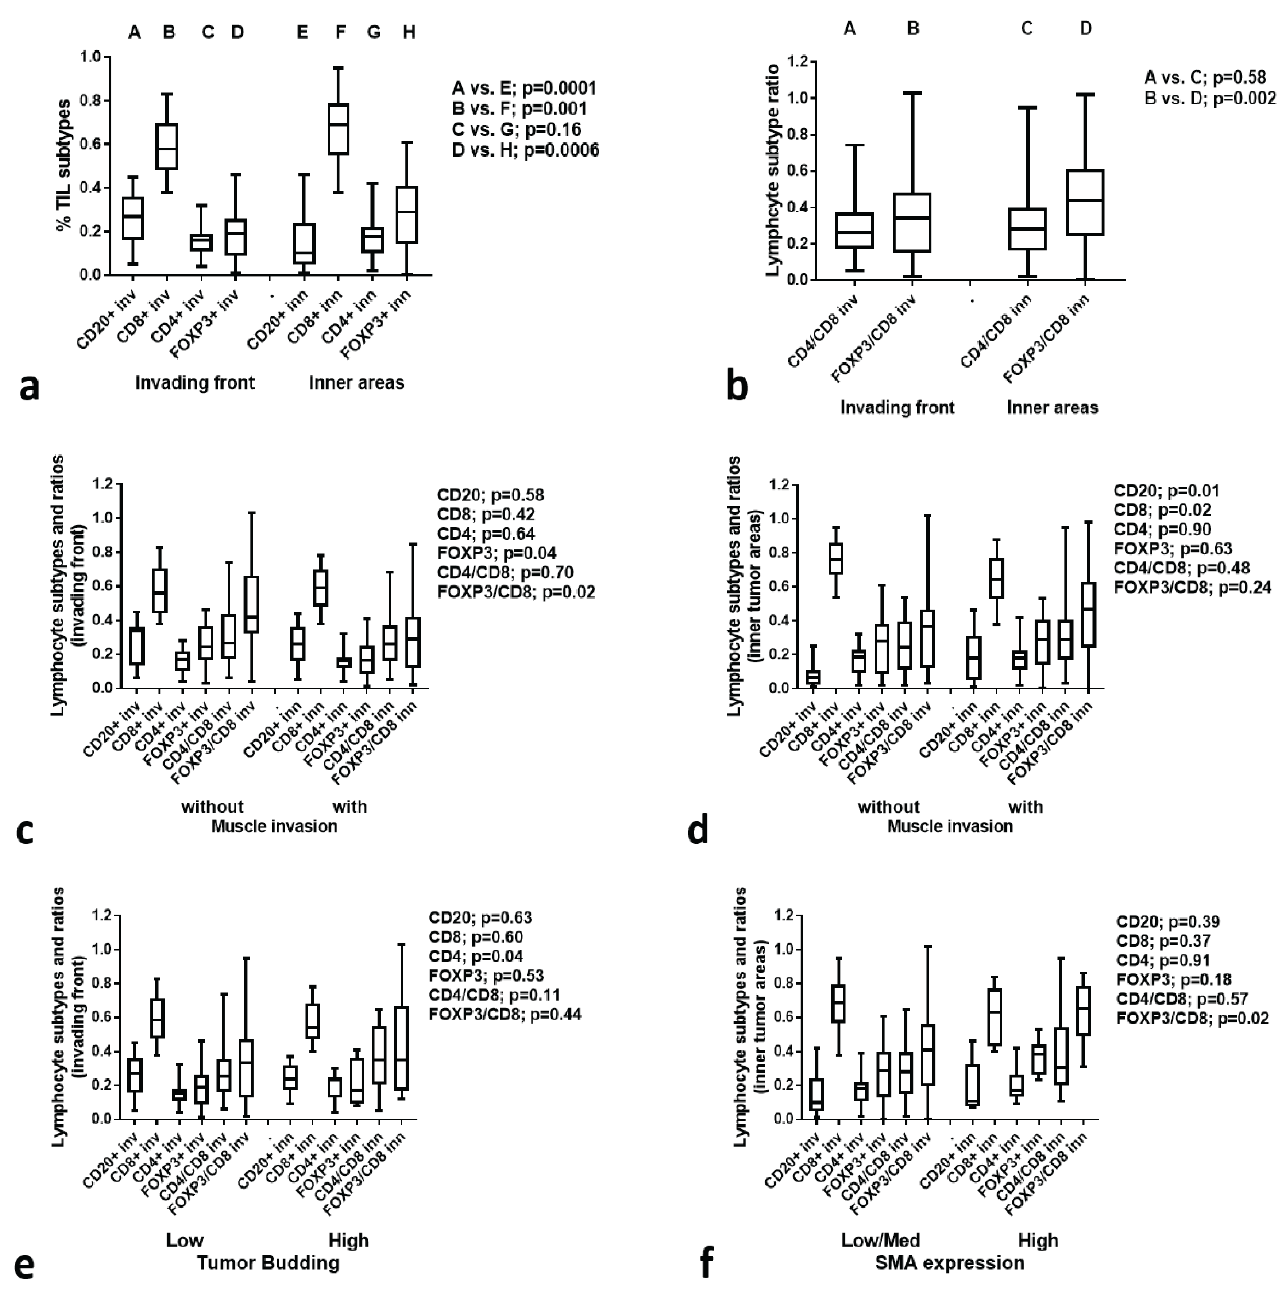
Figure 3. TIL subtypes and ratios: ( a ) TIL subtype composition in the invading front and inner tumor areas; ( b ) TIL subtype ratio in the invading front and inner tumor areas; ( c ) TIL subtypes and ratios in the invading front according to the muscle invasion; ( d ) TIL subtypes and ratios in inner areas according to the muscle invasion; ( e ) TIL subtypes and ratios according to the tumor budding in the invading front ( f ) TIL subtypes and ratios according to the SMA expression in the stroma of inner tumor areas.